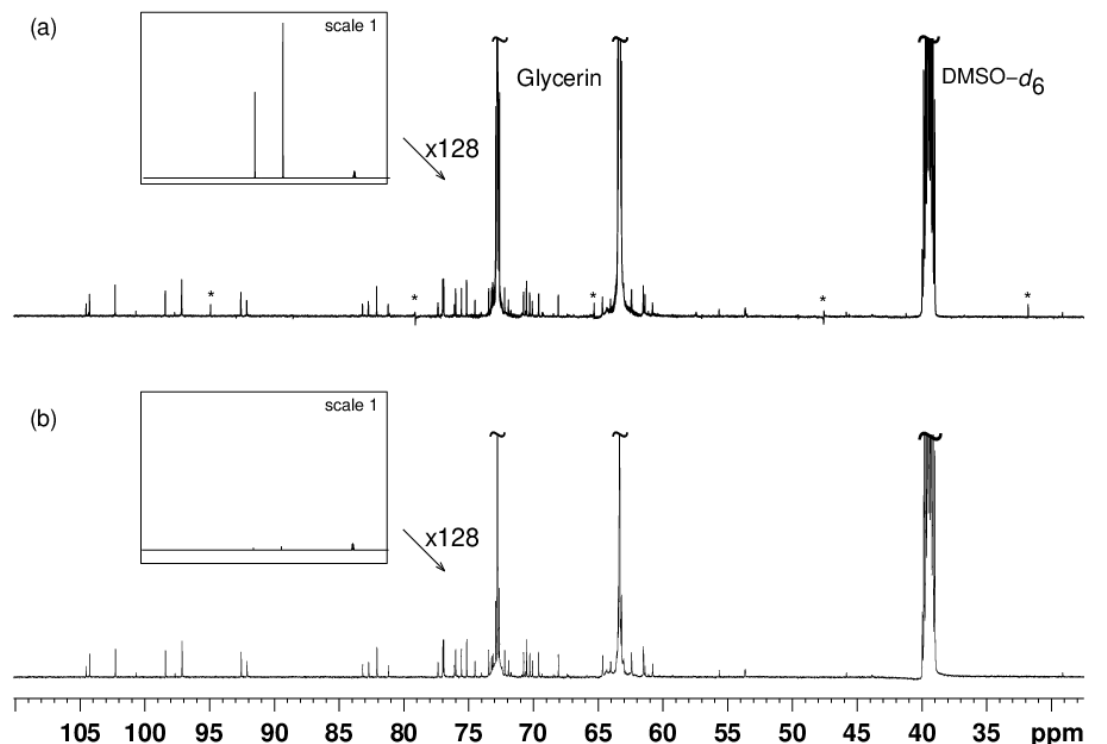
Figure 4. ( a ) 13 C-NMR spectrum of glycerin-containing fraction F 11 . * refers to decoupling artifacts. ( b ) Analysis of the same sample as in ( a ) with multiple presaturation of glycerin signals. The frame inserts show spectra overviews drawn at the same vertical scale, without peak clipping. Both acquisitions required the recording of 1024 scans and eight dummy scans.